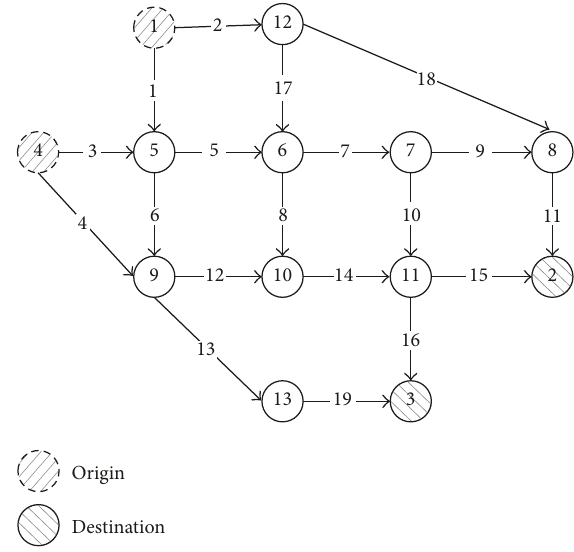
Figure 3: The Nguyen-Dupuis network with 2 origins, 2 destina- tions, 13 nodes, 19 links, and 25 paths between the 4 O-D